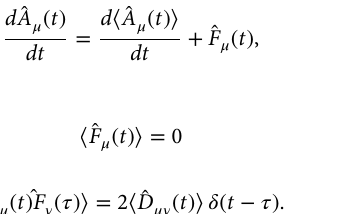
̂𝜎 bb and aa follows those ̂𝜎 aa